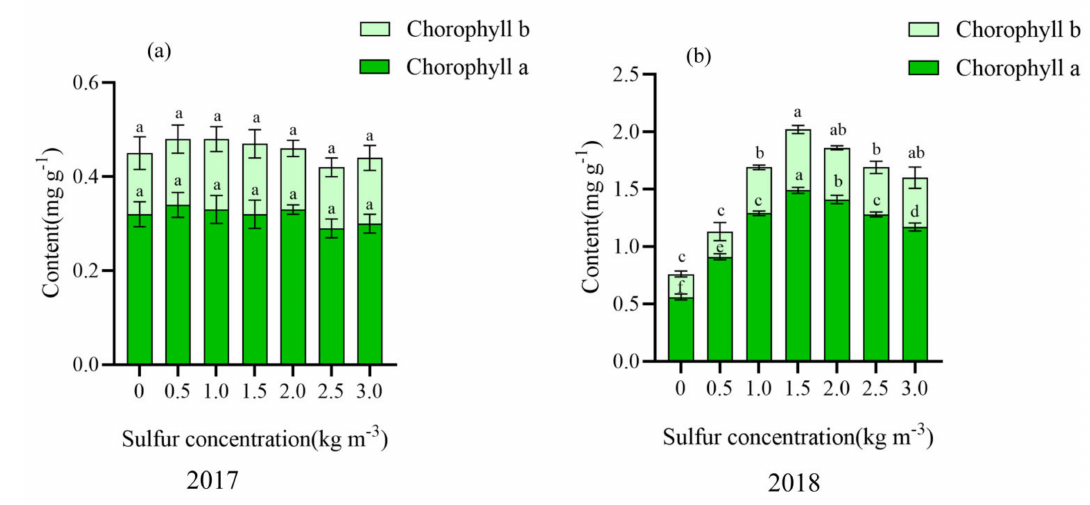
Figure 3. Effect of sulfur on chlorophyll content in kiwifruit leaves. Different letters indicate significant difference between means at p < 0.05. Value are means ± SE (n = 3). ( a ) Chlorophyll content of kiwifruit leaves in 2017; ( b ) Chlorophyll content of kiwifruit leaves in